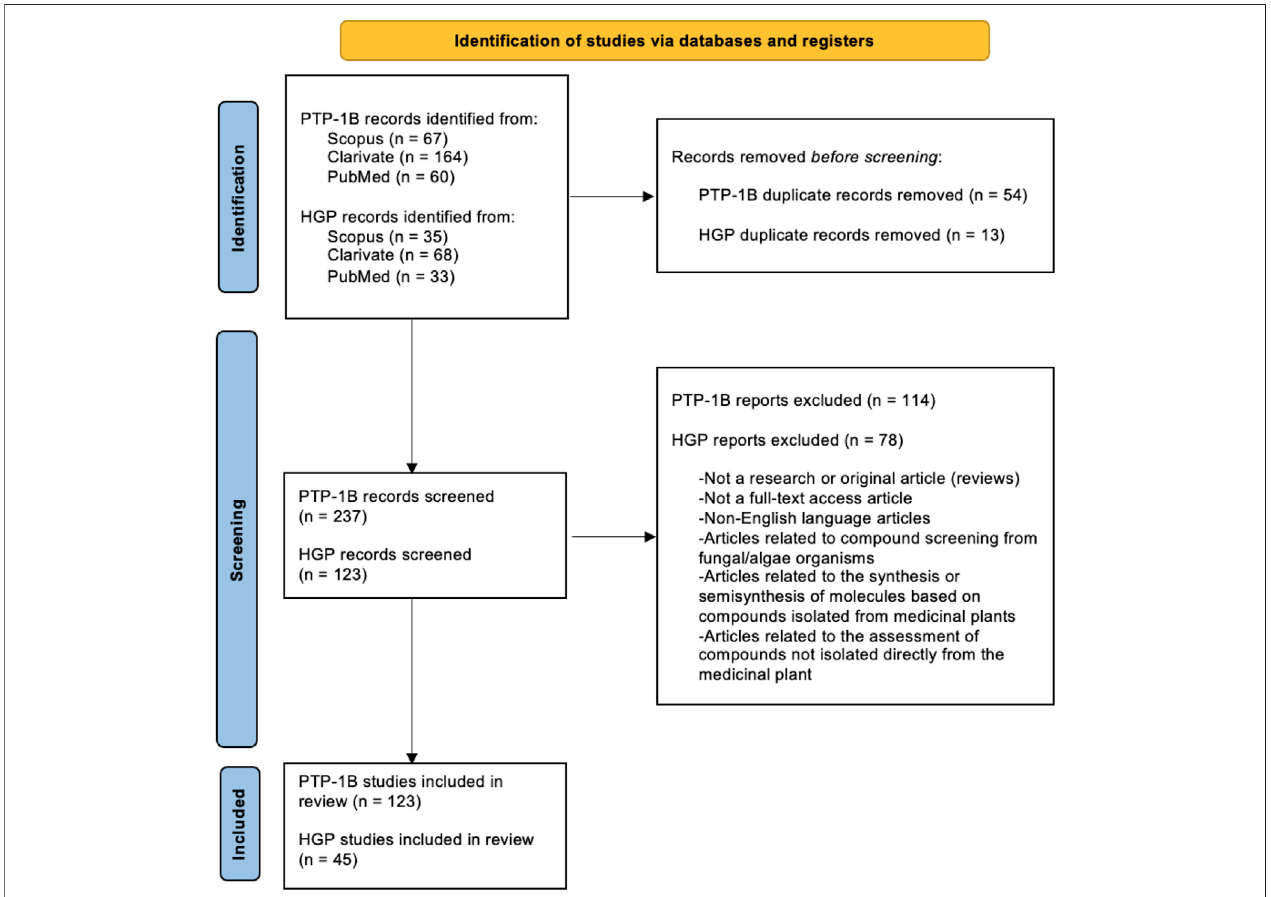
FIGURE 1 | PRISMA fl owchart. PTP-1B: protein tyrosine phosphatase 1B; HGP: hepatic glucose production.